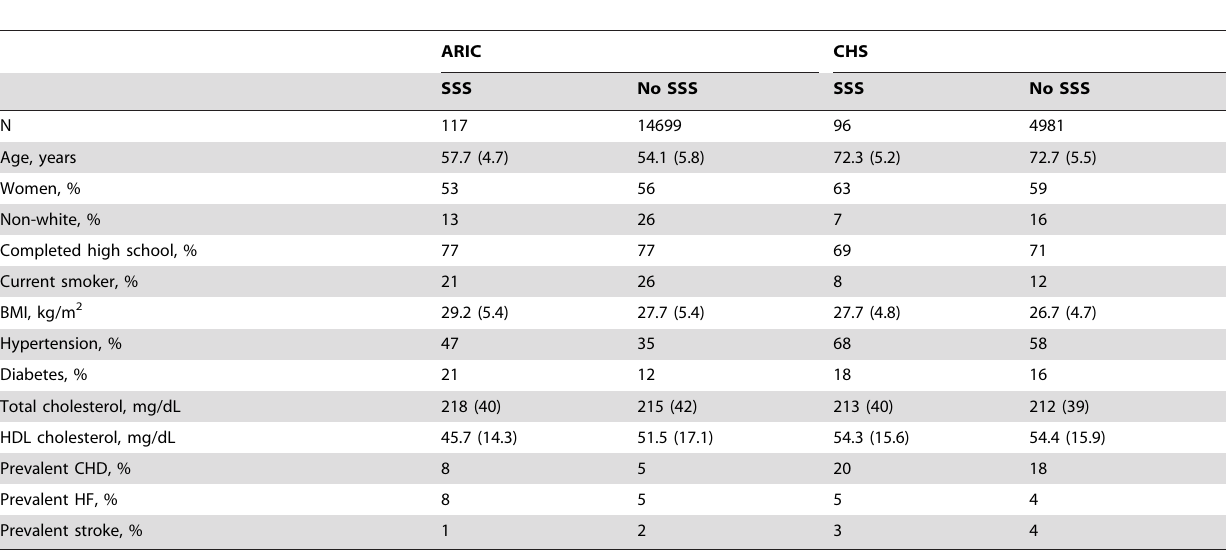
Table 1. Baseline characteristics by sick sinus syndrome (SSS) diagnosis during follow-up, Atherosclerosis Risk in Communities (ARIC) study and Cardiovascular Health Study